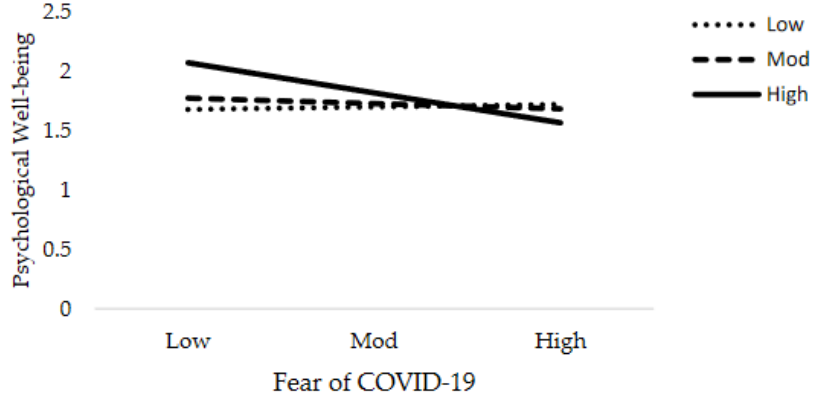
Figure 6. Interactive effect of fear of COVID-19 and social support on Psychological Well-being.